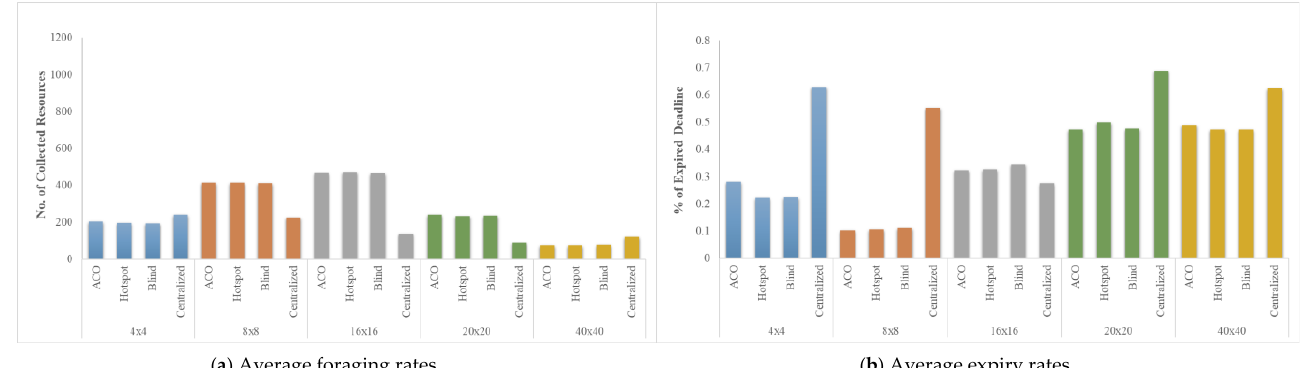
Figure 10. Average robustness of the different methods in terms of the ( a ) foraging and ( b ) expiry rates.